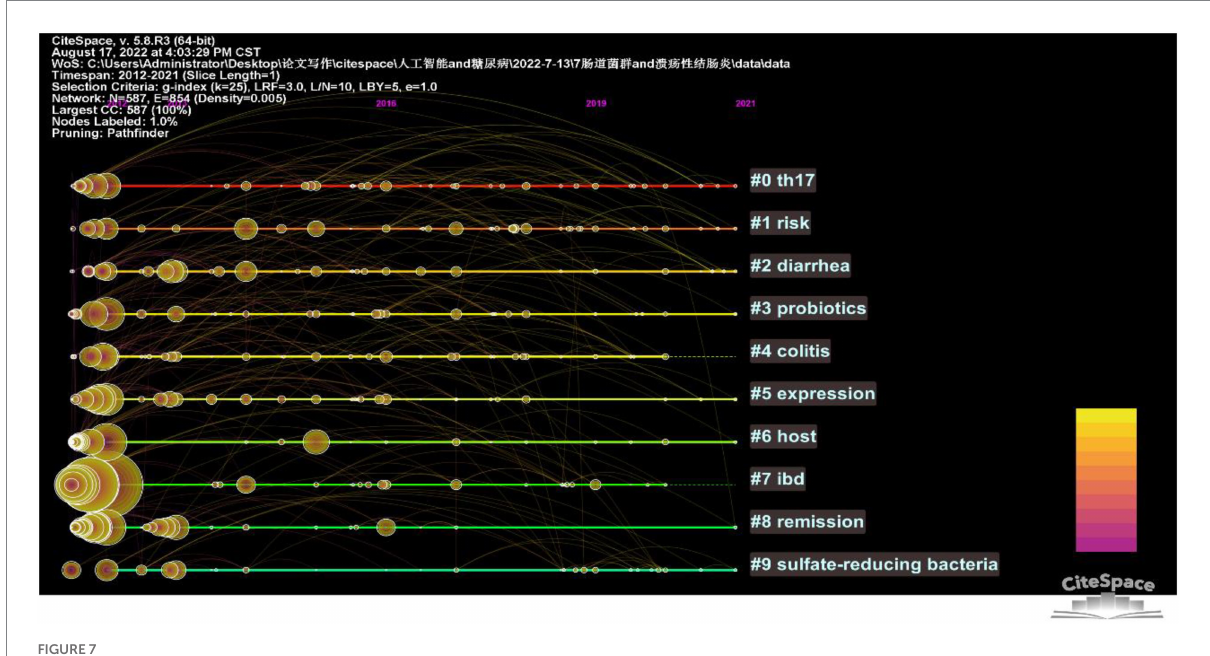
FIGURE 7 Keyword clustering timeline graph.